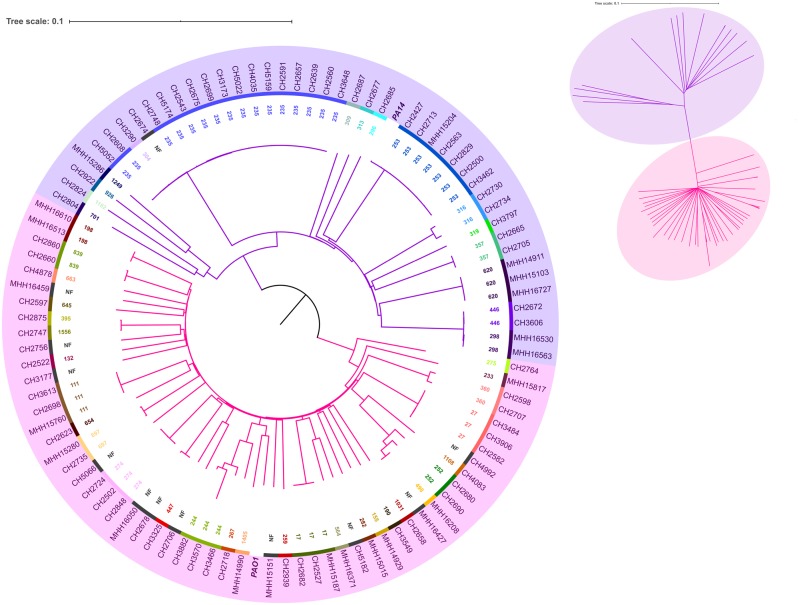
—Broad phylogenetic distribution of the 99 P. aeruginosa clinical isolates. The equal-angle unrooted tree on the top right indicates that the isolates separate into two clonal complexes. The midpoint rooted circular tree highlights in pink the PAO1-like isolates and in violet the PA14-like isolates. Strain types PAO1 and PA14 highlighted in bold. ST information is shown as an inner ring at different color scale. NF indicates newly identified STs that are not found in the database.